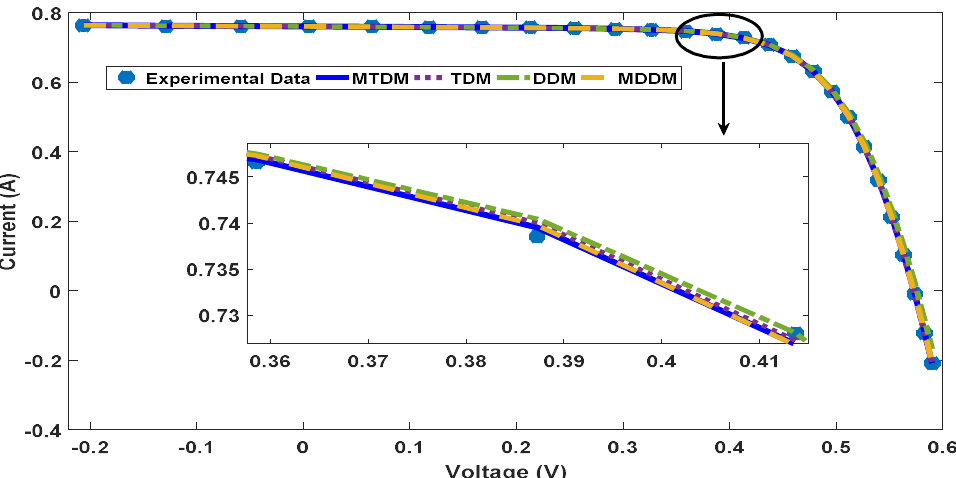
Figure 14. Current–voltage characteristic curve comparison between real data and all estimated models by WHO.